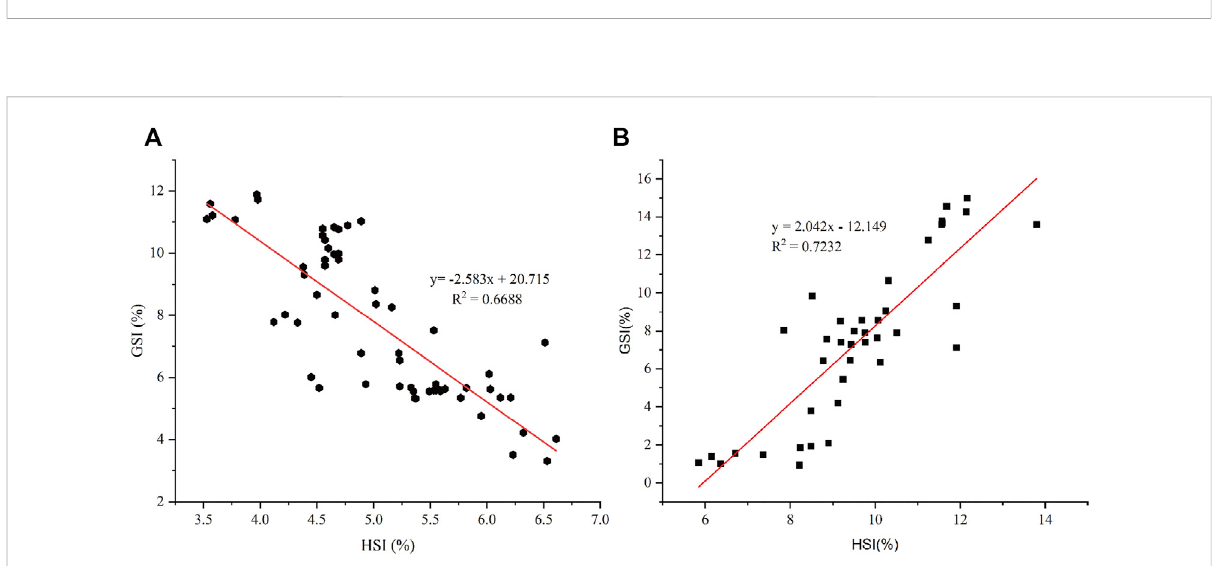
FIGURE 7 ThecorrelationbetweenHSIandGSI. (A) CorrelationbetweenHSIandGSIinovarianstage Ⅳ and Ⅴ duringtheSVP. (B) CorrelationbetweenHSI and GSI during the